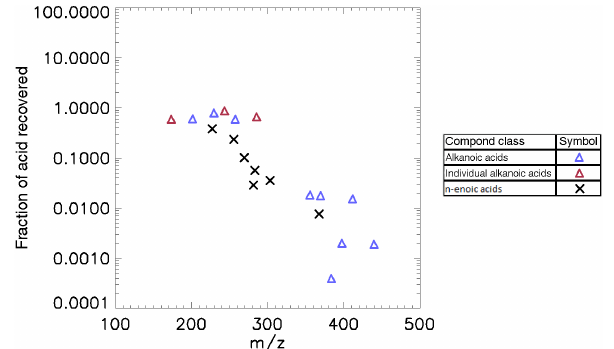
Figure 2. The ratio of the amount of a substance on the filters mea- sured with the offline TD-PTR-MS technique to the known amount of the substance put on the filters (fraction of acid